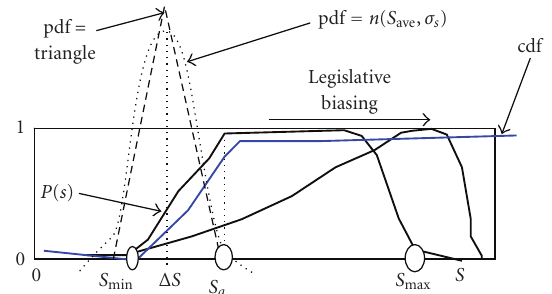
Figure 3: Relationship between simple fuzzy function and a pdf